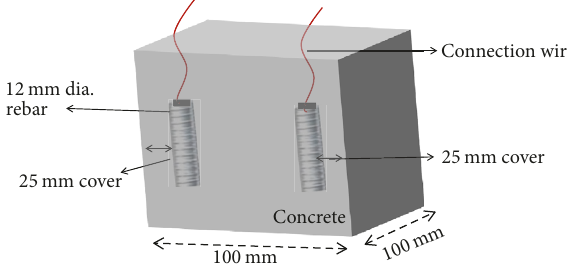
Figure 2: Schematic representation of concrete cube specimen used for potentiodynamic polarization and AC-impedance